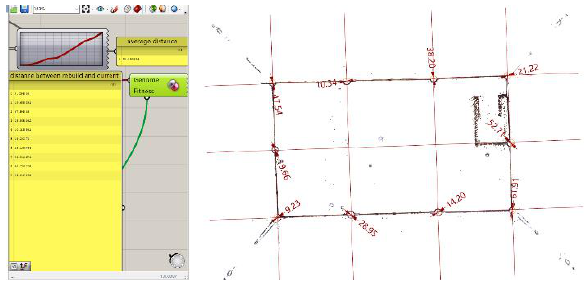
Figure 15. the grid system of the third